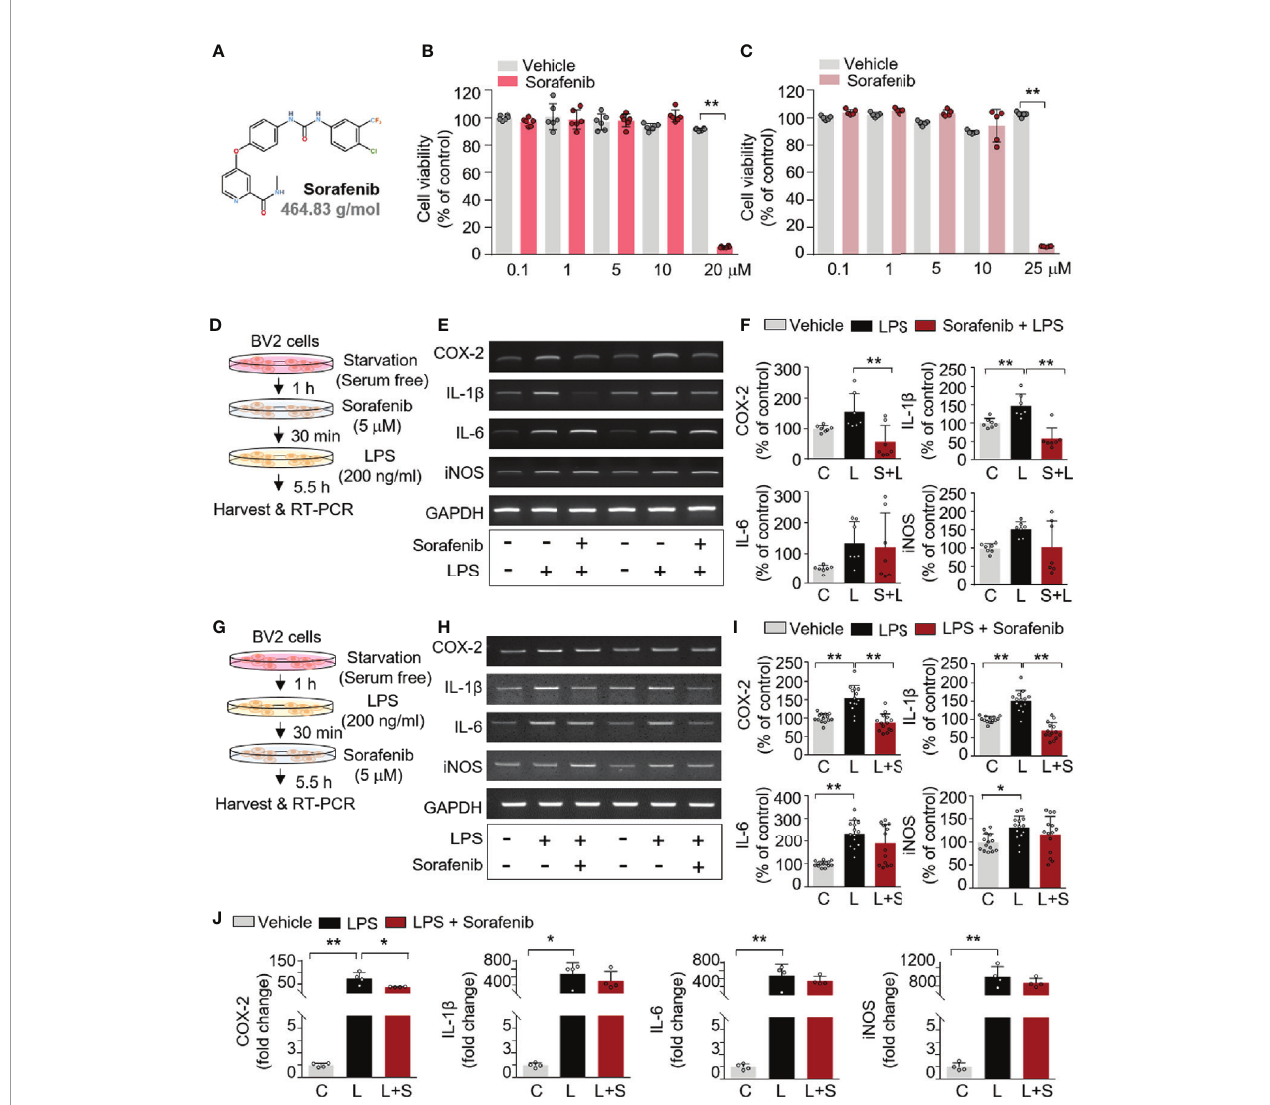
FIGURE 1 | Sorafenib decreases LPS-induced proin fl ammatory cytokine levels in vitro . (A) Structure of sorafenib. (B, C) The cytotoxicity of sorafenib due to mitochondrial arrest was assessed by the MTT assay in BV2 microglial cells treated for 6 or 24 h with a range of concentrations (0.1, 1, 5, 10, and 20 or 25 m M) or vehicle (1% DMSO) (6 h, n= 6/dose; 24 h, n= 5/dose). (D) Scheme for pre-treatment of BV2 cells with sorafenib. (E, F) RT-PCR analysis of proin fl ammatory cytokine levels in BV2 cells treated as described in (D) (n=7/group). (G) Scheme for post-treatment of BV2 cells with sorafenib. (H, I) RT-PCR analysis of proin fl ammatory cytokine levels in BV2 cells treated as described in (G) (n= 14/group). (J) Real-time PCR analysis of proin fl ammatory cytokine levels in cultured primary astrocytes (n= 4/group). *p < 0.05, **p <